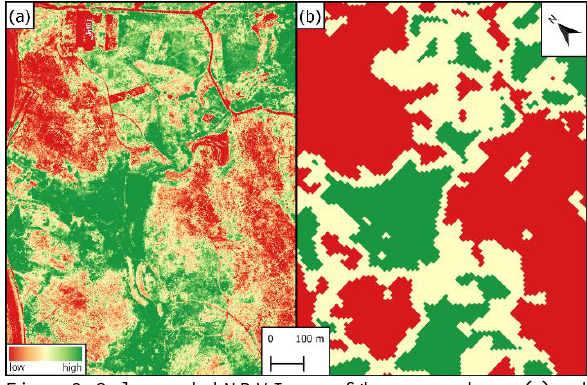
Figure 3. Colour coded NDVI map of the surveyed area (a) and its smoothed three-class NDVI map.